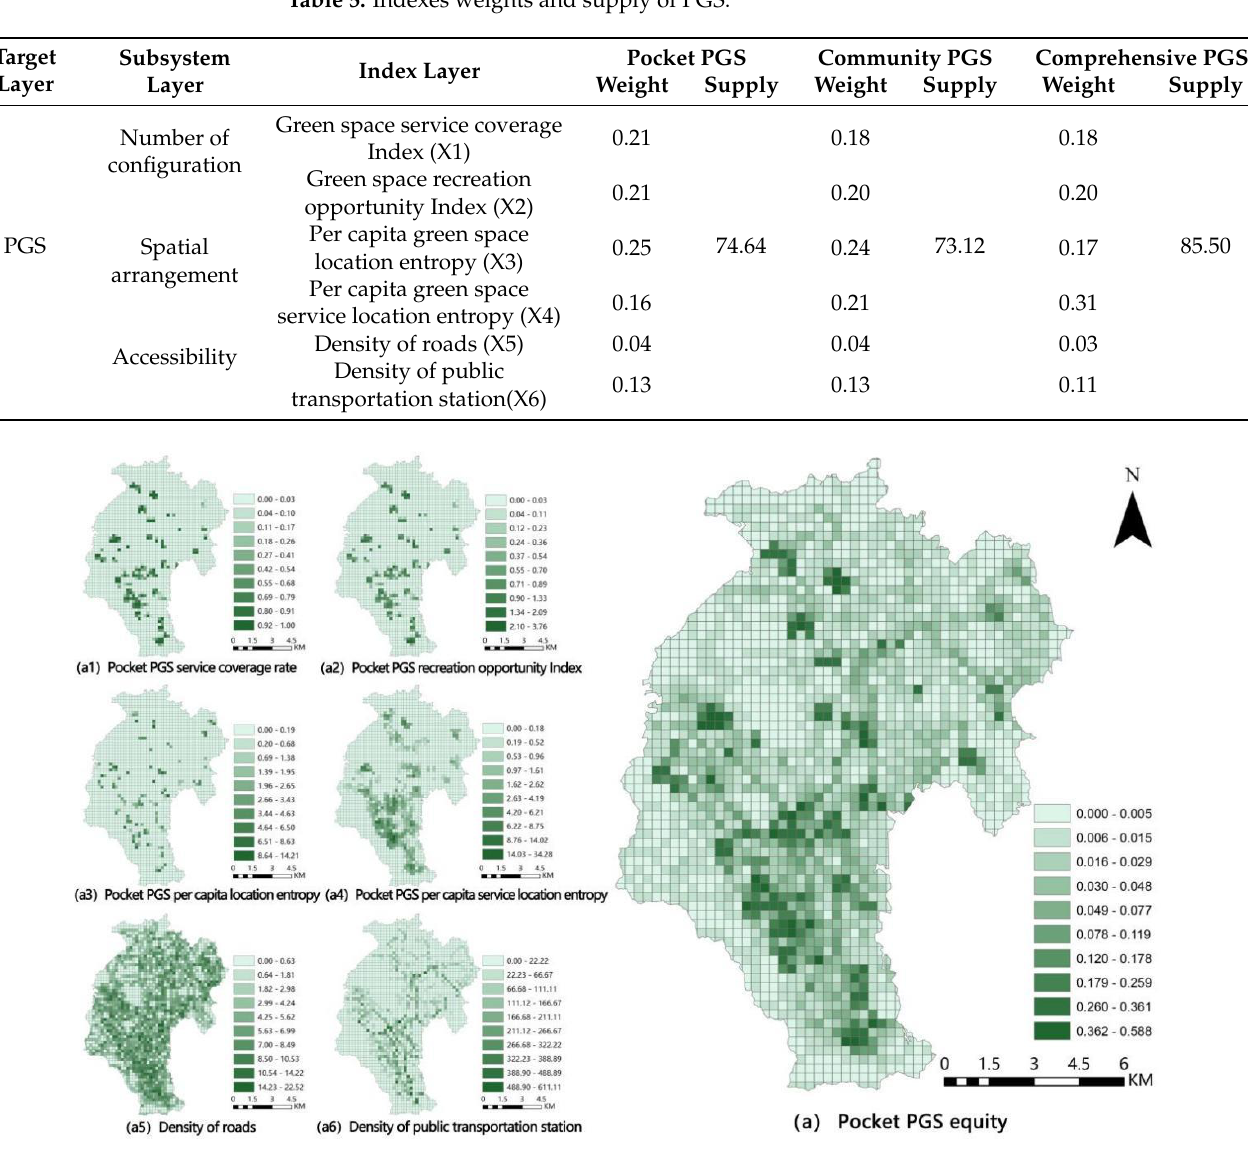
Table 5. Indexes weights and supply of PGS.